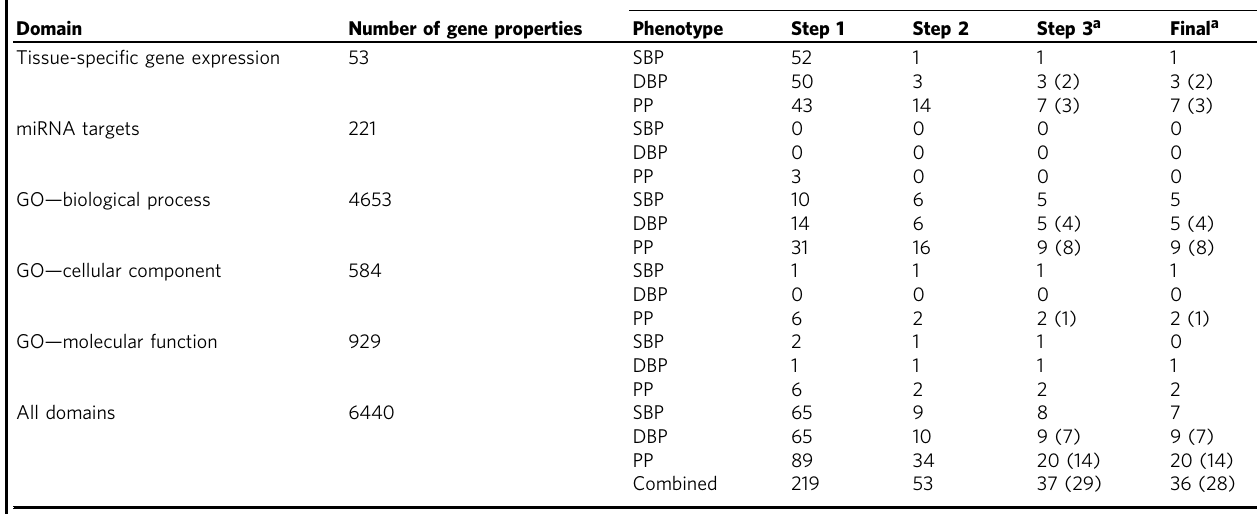
Table 1 Overview of the number of initially signi fi cant gene properties retained in each step Number of signi fi cant and retained gene